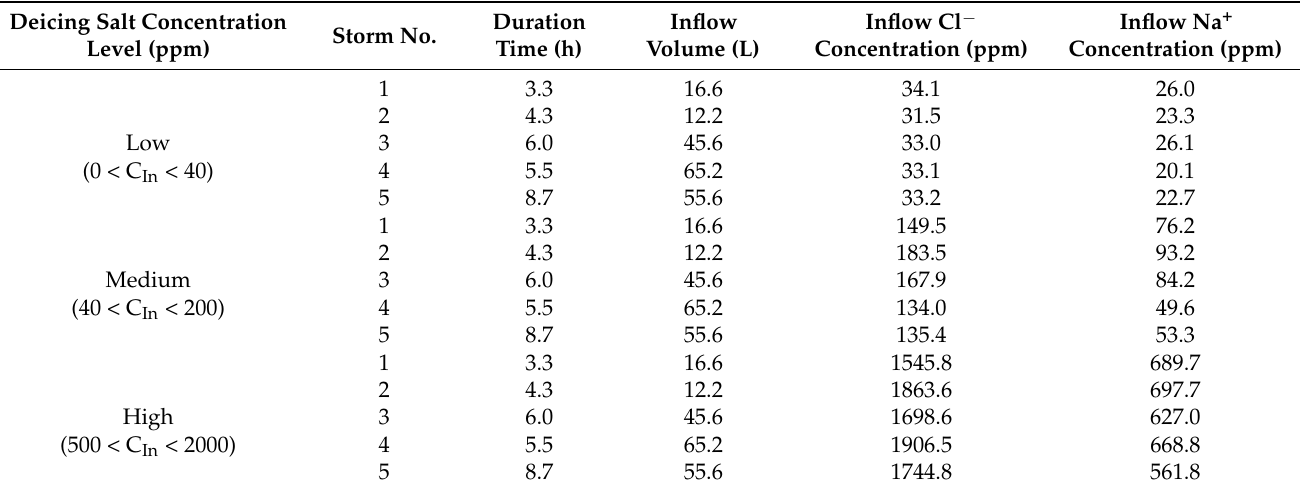
Table 3. Design specifications and other characteristics for synthetic storm events (C In : concentration of